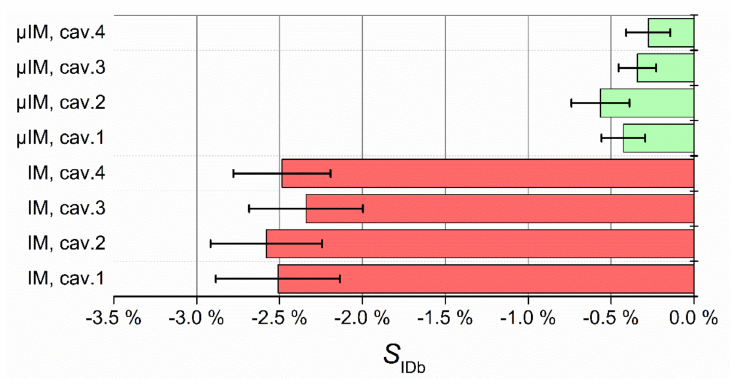
Figure 14. Replication results for IDb. The interval bars represent the 95% confidence intervals for the mean.